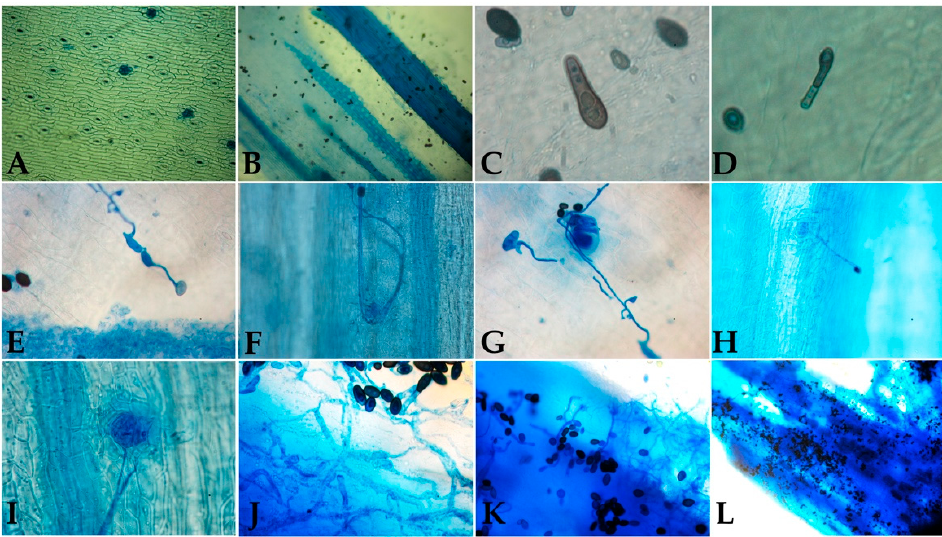
Figure 5. Infection process of O × G oil palm hybrid seedlings after T. paradoxa inoculation with a 1 × 10 6 endoconidia mL − 1 suspension using the local infiltration method. ( A ) Healthy oil palm petiole tissue (10× magnification). ( B ) Six hpi (10× magnification). ( C ) Germ tube formation 12 hpi (100× magnification). ( D ) Septum formation and hyphae colonization 18 hpi (100× magnification). ( E ) Hyphae connections 24 hpi. ( F , G ) Hyphae around the stomata (100× magnification). ( H , I ) Germinated endoconidium with hyphae advancing towards the stoma (10× and 100× magnification, respectively). ( J ) Tissue colonization 36 hpi (40× magnification). ( K , L ) Sporulation process between 76 hpi and 96 hpi (40× and 10× magnification, respectively). hpi = hours post-inoculation.